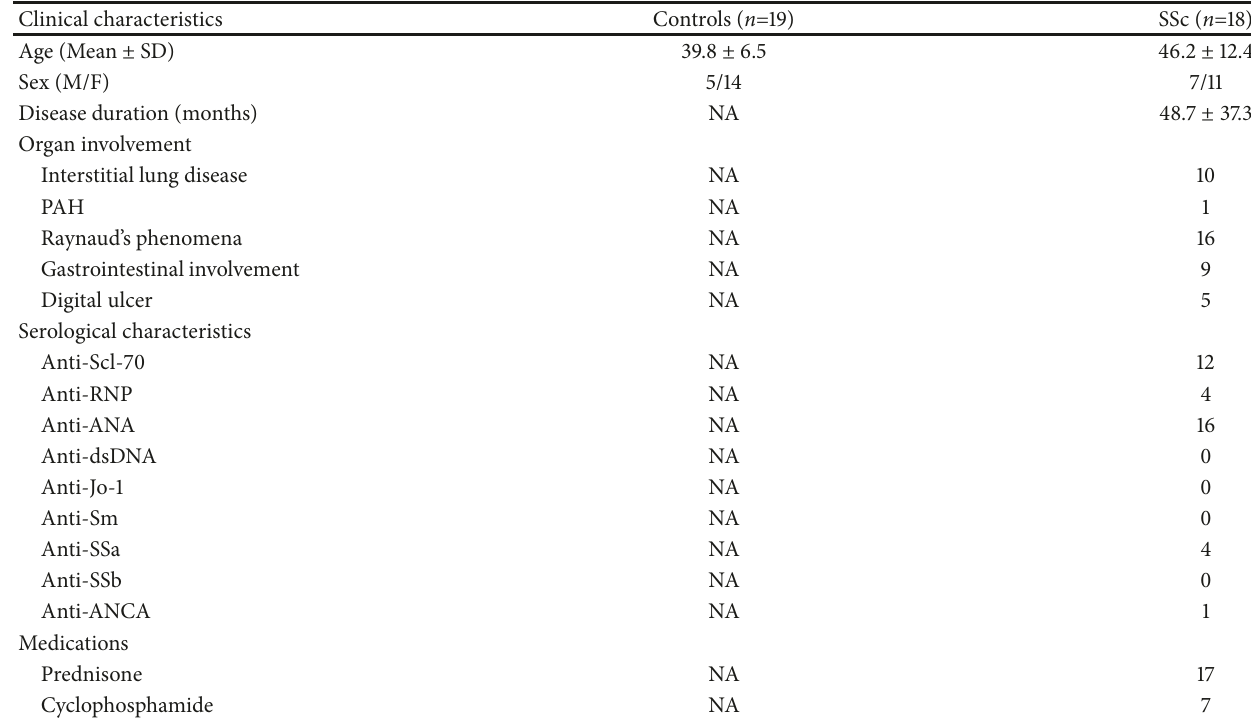
Table 1: Characteristics of clinical subjects and healthy